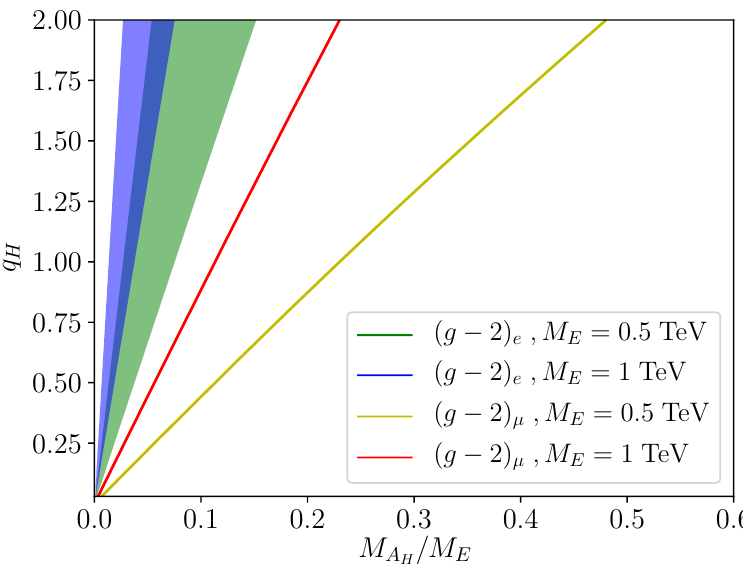
Figure 17 . Region that explains the electron g − 2 anomaly for M E = 500 GeV (green) and M E = 1 TeV (blue). The 2 sigma limits from the contribution to the muon g − 2 are shown with solid lines, for M E = 500 GeV (yellow) and for M E = 1 TeV (red). The region above the lines is